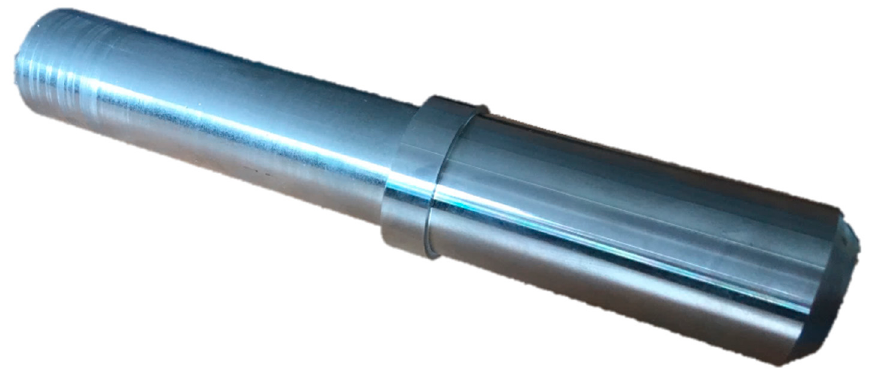
Figure 2. The part under consideration.